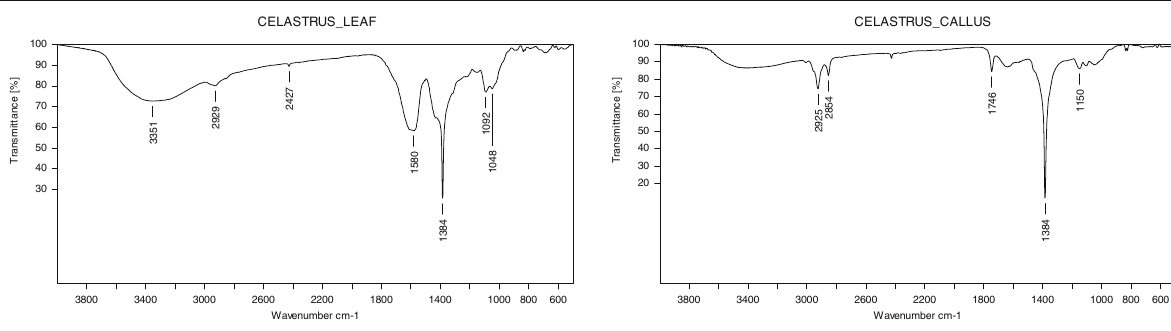
Fig. 4 FTIR spectra of CP extract in the range 4000 – 500 cm − 1 at a resolution of 2 cm − 1 . a Leaf extract. b Callus